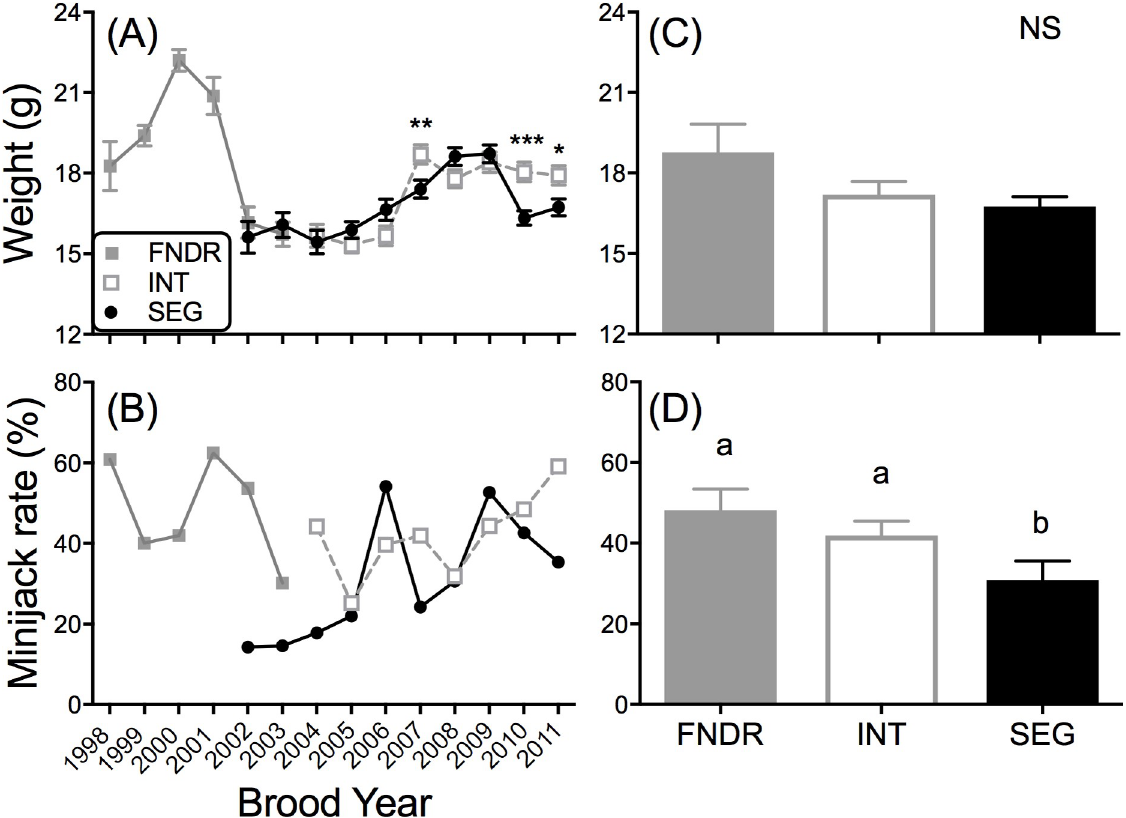
Fig 4. Year-to-year variation in body weight at release and age-2 minijack rate at Clark Flat acclimation site. ( A) Mean body weight (g) of males at release and (B) percent age-2 minijacks among males for BYs 1998–2011; and the across brood year averages for each broodline for (C) body weight and (D) age-2 minijack rate. The founding hatchery line (FNDR) was produced from wild-origin broodstock (BYs 1998– 2003). The integrated (INT) broodline began in 2004 and uses only unmarked (natural-origin; could have hatchery-reared grandparents) returning adults for broodstock. The segregated (SEG) broodline began in 2002 using returning hatchery-origin adults for broodstock. Error bars = SEM. Different letters above bars represent a significant difference between broodlines ( α = 0.05). � P < 0.05, �� P < 0.01, ��� P < 0.001.